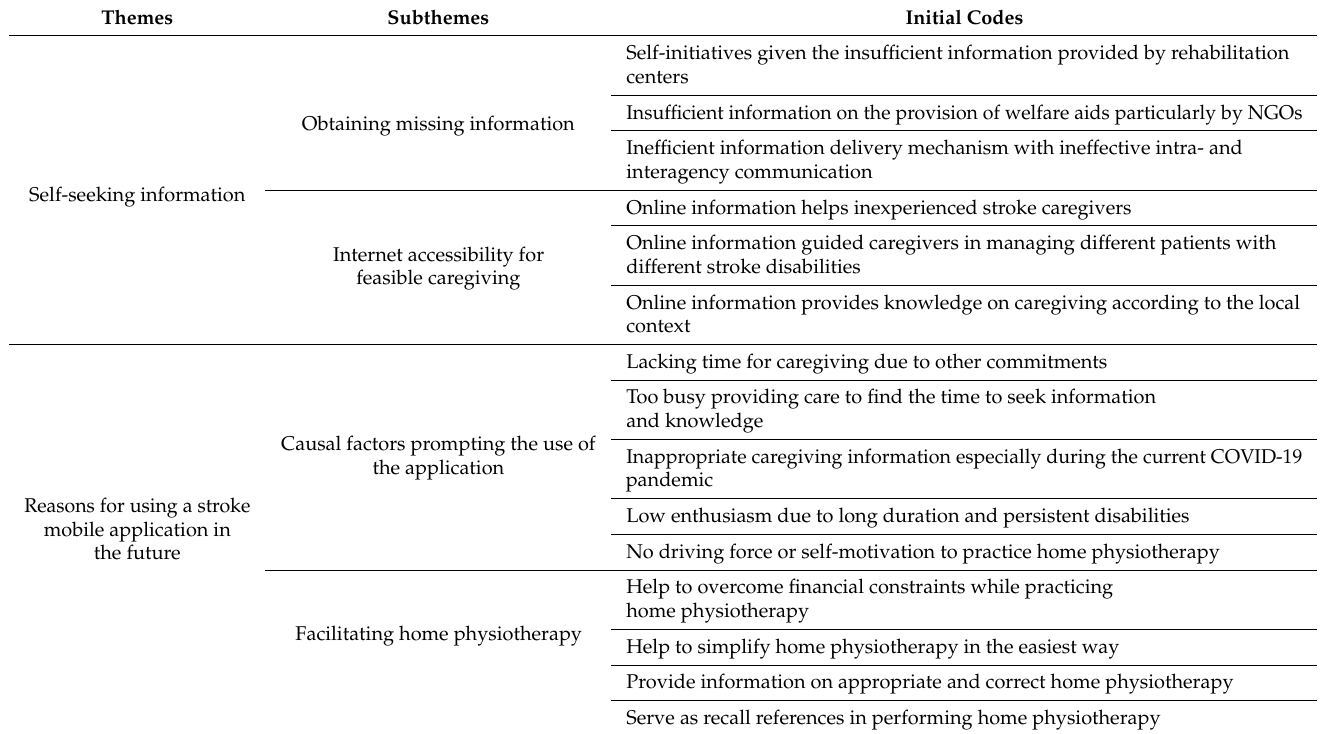
Table A2. Themes and subthemes regarding the need for a mobile application for managing stroke patients by informal